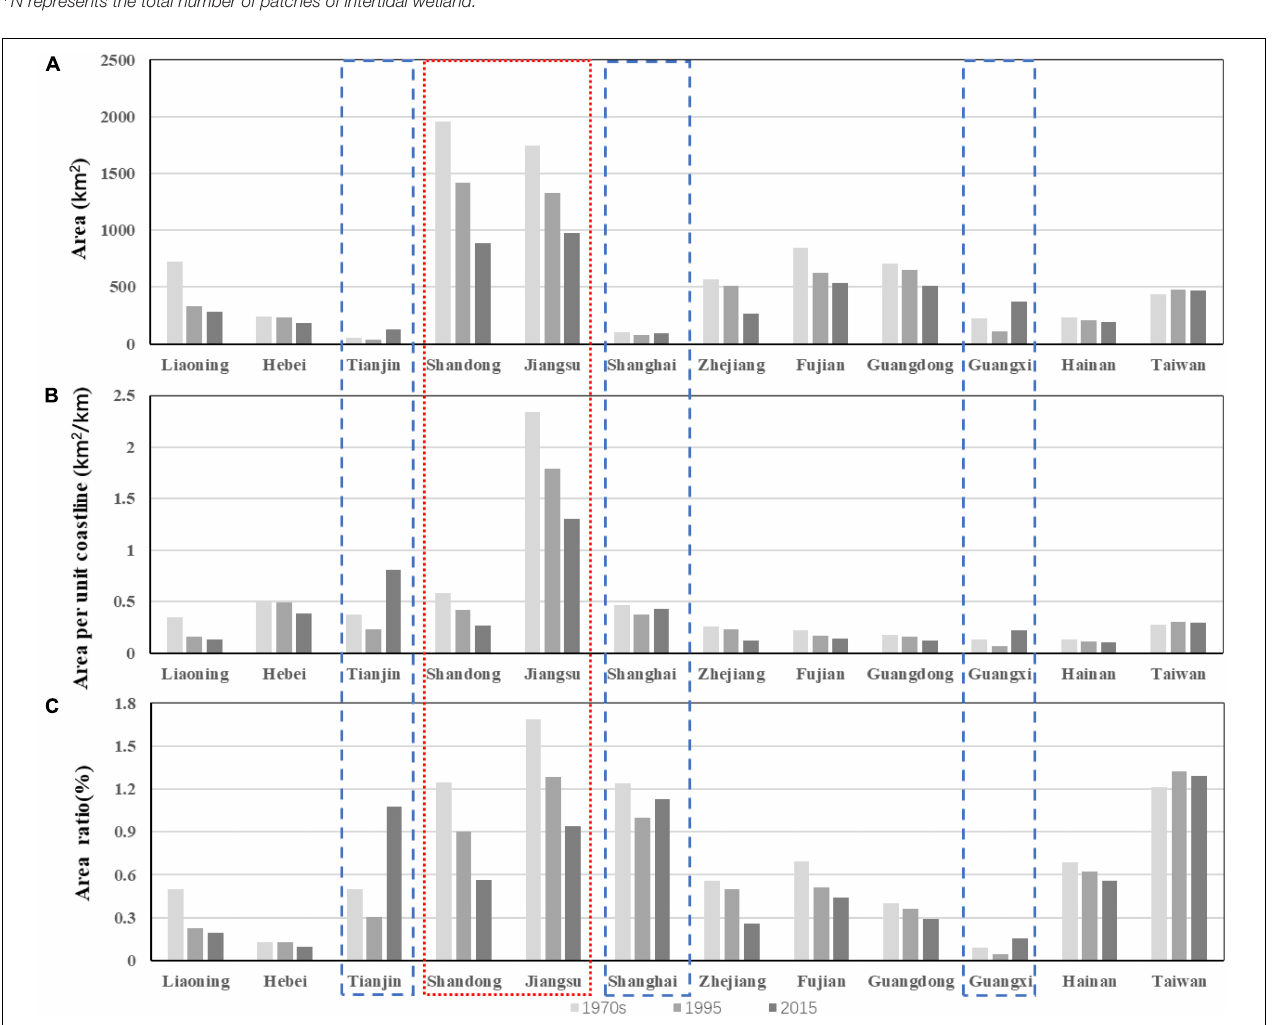
FIGURE 5 | Decrease in the intertidal area of each administrative region, (A) total area, (B) area per coastal line, (C) intertidal area to provincial area ratio. The regions in the red dotted rectangule are the major contributor to the degradation of the intertidal wetland area, while those in blue dashed rectangles represent the areas that increased in the later